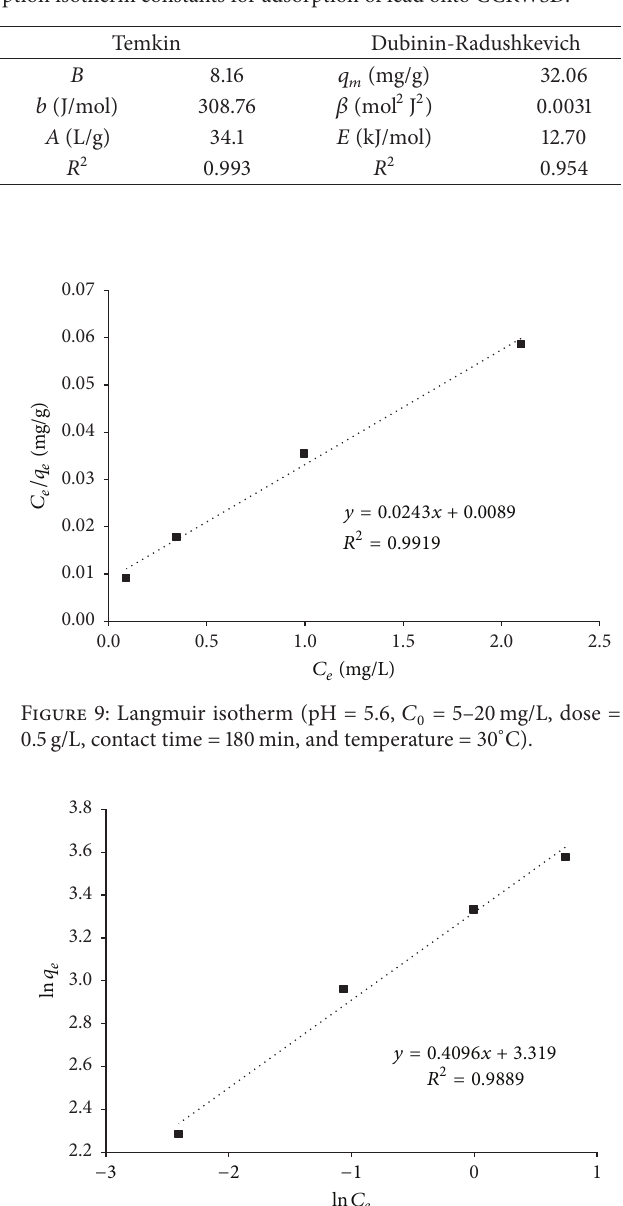
Table 1: Parameters of Langmuir, Freundlich, and Temkin adsorption isotherm constants for adsorption of lead onto CCRWSD.